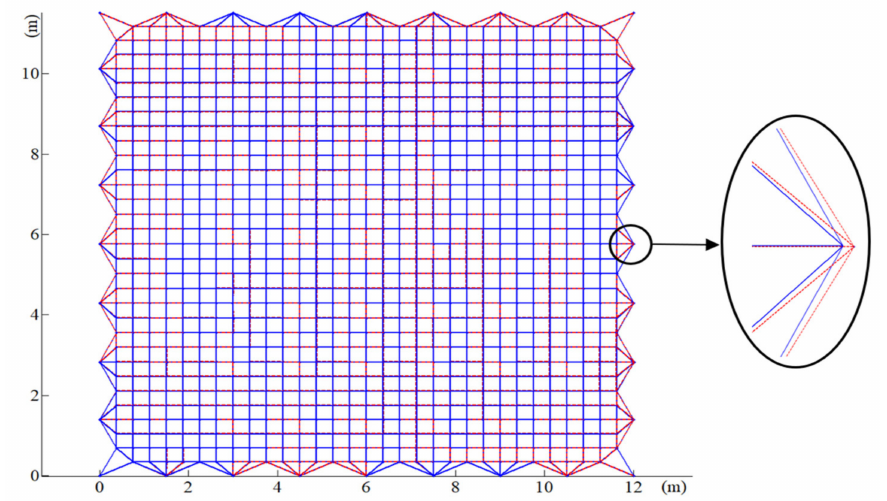
Figure 18. The form-finding configuration of the mesh reflector.